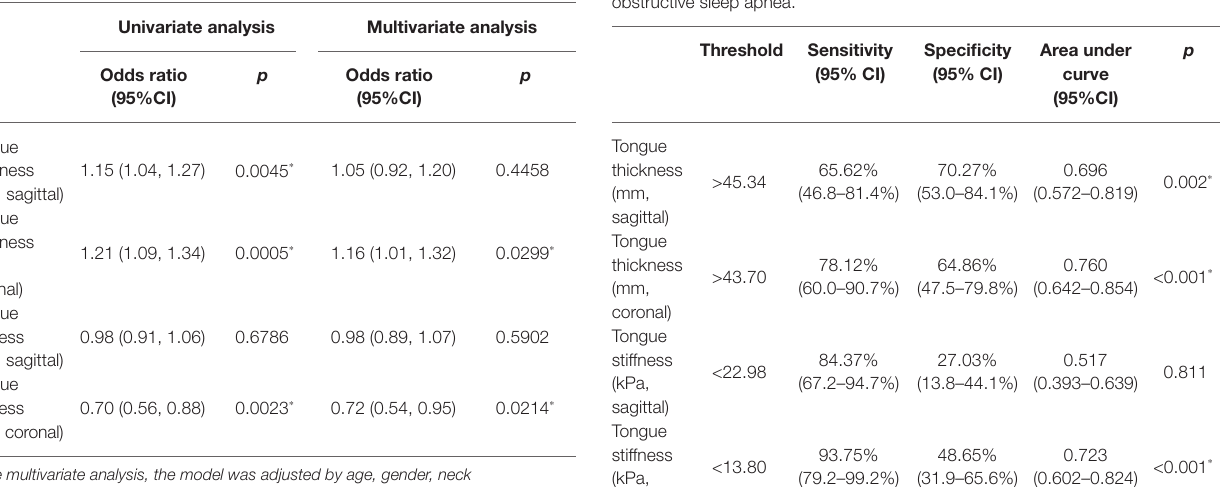
TABLE 3 | Association between obstructive sleep apnea and ultrasound measurements of tongue thickness and stiffness.